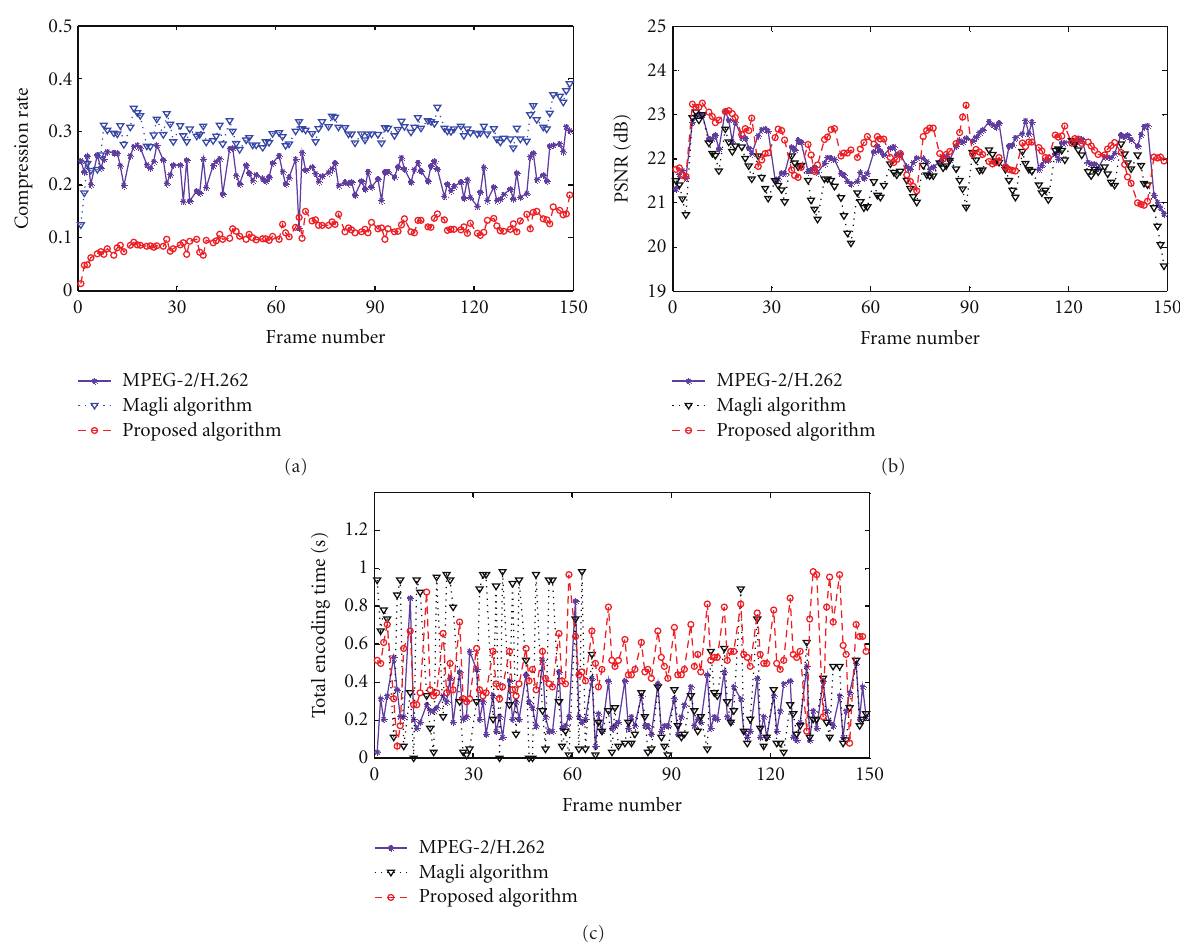
Figure 12: Simulation results with the Carphone video: (a) the compression rate, (b) the quality of video, and (c) the total encoding time.